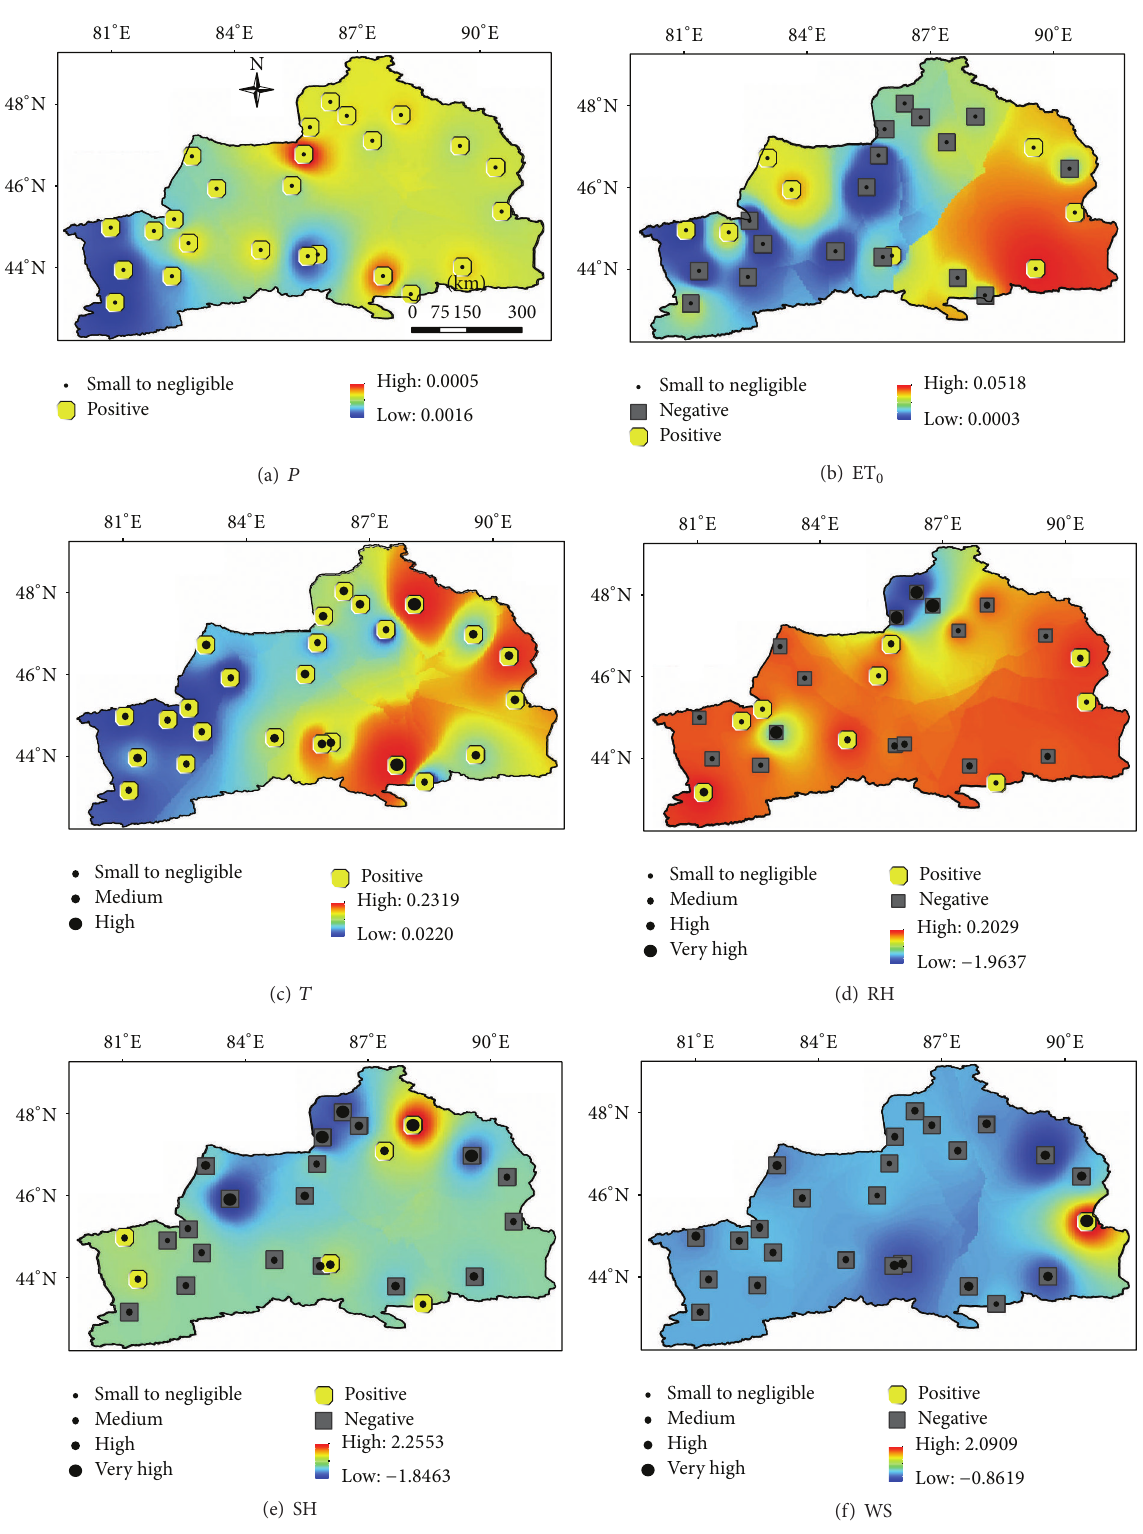
Figure 6: Spatial distribution of the sensitive coefficients associated with six meteorological factors to AI in North Xinjiang,